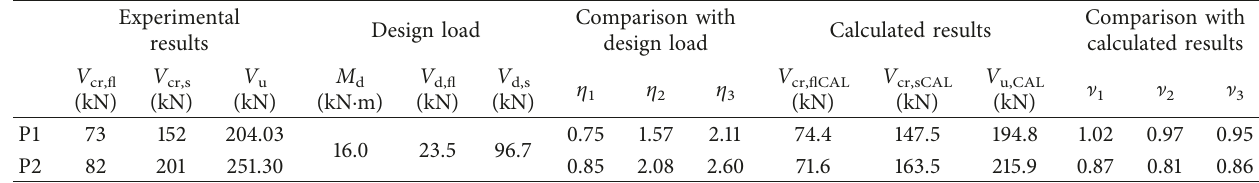
Table 6: Comparison of experimental results with the design load and calculated results.